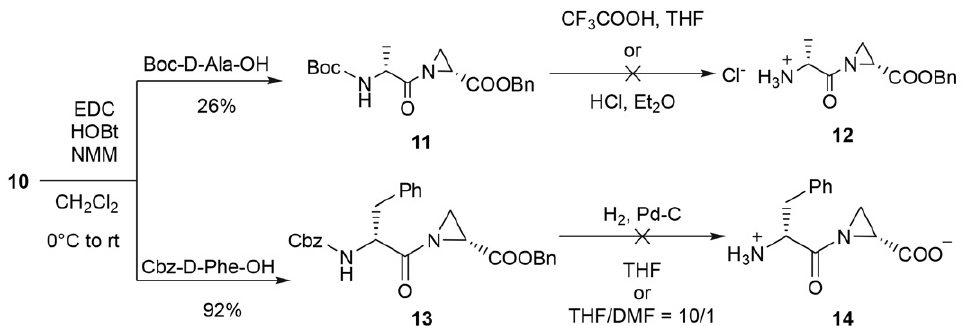
Figure 4. Study on the preparation of 12 and 14